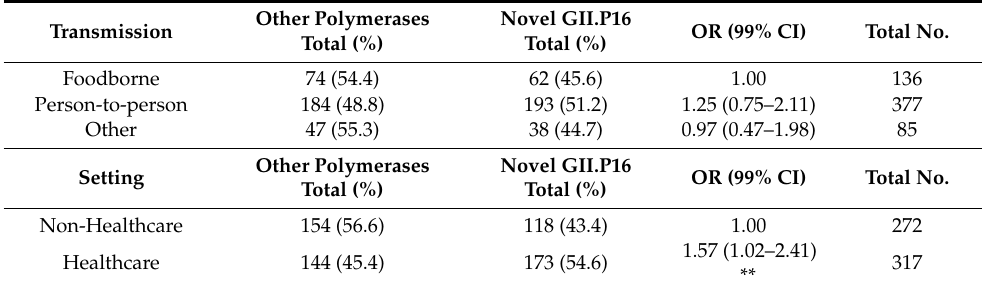
Table 1. Number of norovirus outbreaks by polymerase type, transmission, and outbreak setting *. Other Polymerases Novel GII.P16 OR (99% CI) Total No. Transmission Total (%) Total (%) Foodborne